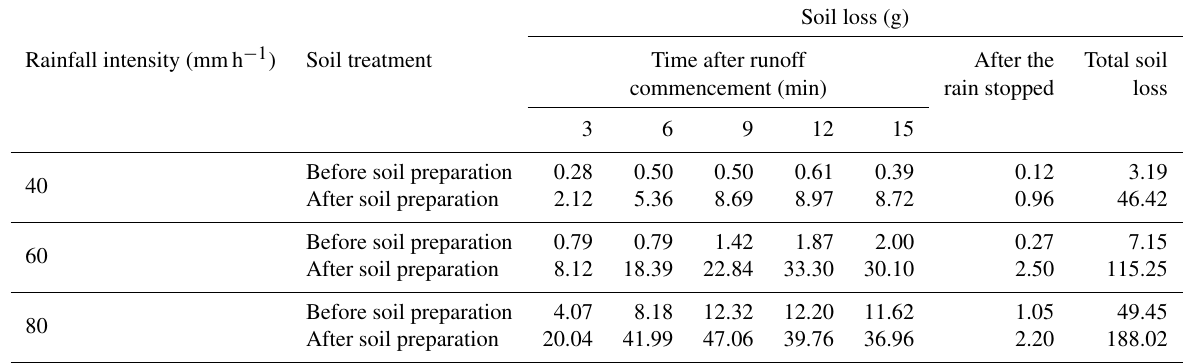
Table 3. The average soil loss for three replicates of both before and after soil preparation treatments in three studied rainfall intensities. Soil loss (g) Rainfall intensity (mmh − 1 ) Soil treatment Time after runoff After the Total